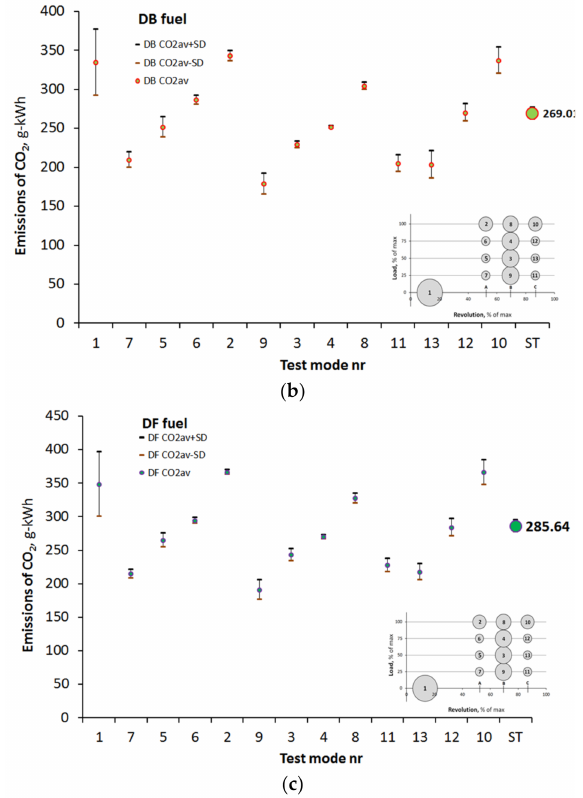
Figure 7. Emissions of CO 2 of engine in ESC 13 mode test fed with D ( a ), with DB fuel ( b ), and with DF fuel ( c ).